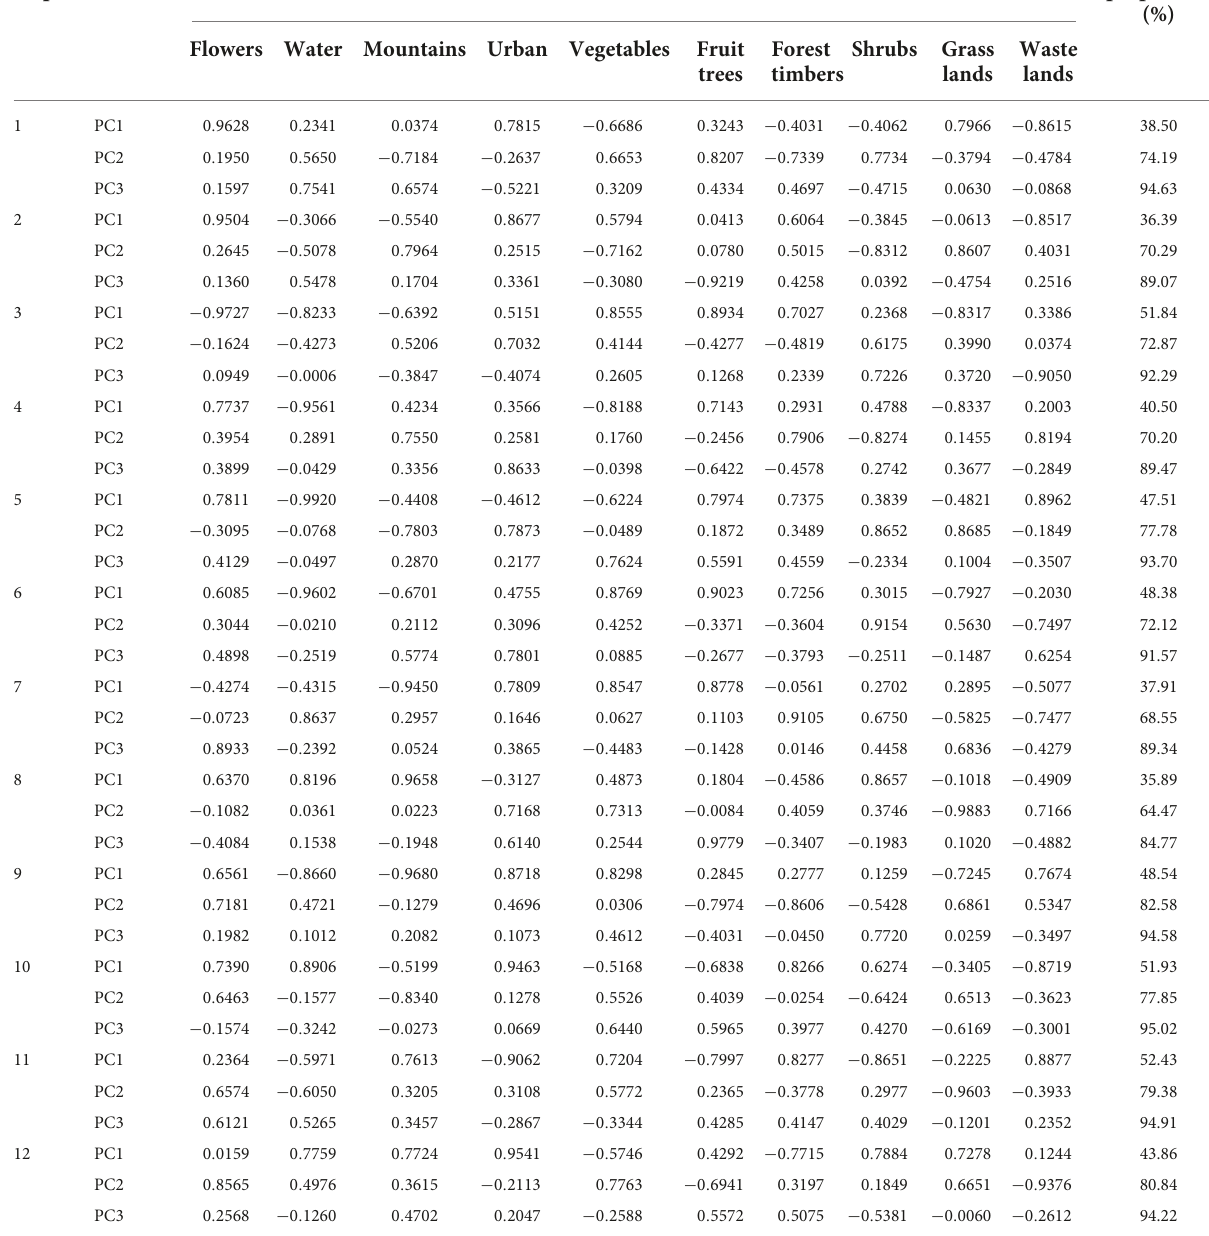
TABLE 2 Eigenvalues of the covariance matrix and cumulative proportion of principal components at each agriculture landscape in 2018. Land PC scapes